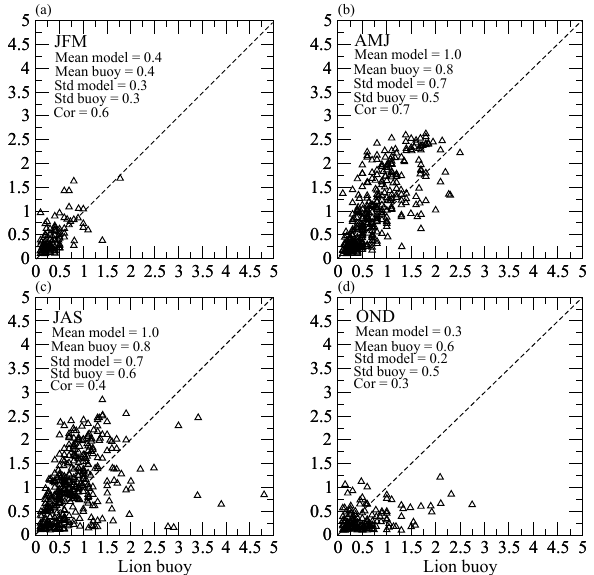
Figure 4. Amplitude in ◦ C of the 2009–2013 SST diurnal cycle for the Lion buoy ( x -axis) and the model simulation ( y -axis), according to the season: (a) JFM, (b) AMJ, (c) JAS and (d) OND. Only values above 0.1 ◦ are kept. Mean values and standard deviations are given for each season, as well as the daily temporal